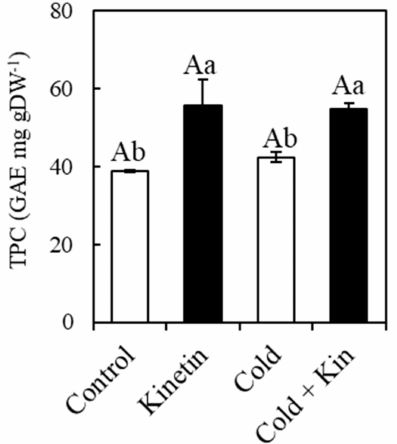
Figure 5. E ff ect of exogenous kinetin on total phenolic content (TPC) expressed on the basis of gallic acid equivalent (GAE) in the leaves of co ff ee plants under optimum and cold stress conditions. Kin, kinetin. Di ff erent capital letters denote the statistically significant di ff erences between the parameter means within temperature treatments, whereas di ff erent small letters denote statistically significant di ff erences for the parameter means within kinetin treatments ( p < 0.05, Newman–Keuls test). Means are a replicate of three independent samples ( n = 3). Error bars represent the standard deviation of the mean.